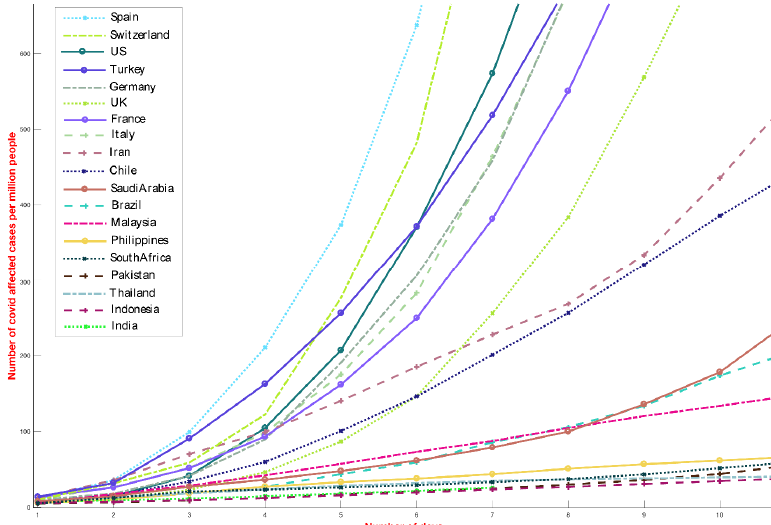
Figure 1. Incidence curve of COVID-19 cases for different countries (until 1 May 2020). The figure shows the total number of cases (normalized by the population of the country) starting from 5 persons affected per million. Different regions and states clearly follow different incidence curves. The y -axis has been capped at 600 cases per million. The countries were chosen as the top 9 countries from cold and dry weather and top 10 from hot and humid weather by 1 May. The countries are listed in Table S1, together with their classification of hot, humid / cold, dry and other demographics and weather information.